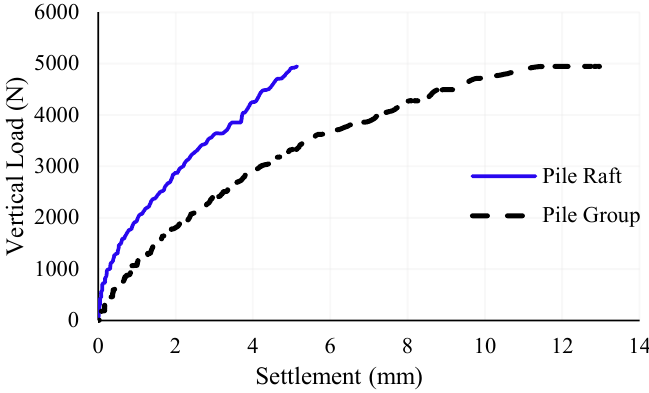
Figure 16. 9-pile group vs. 9-piled raft vertical response.